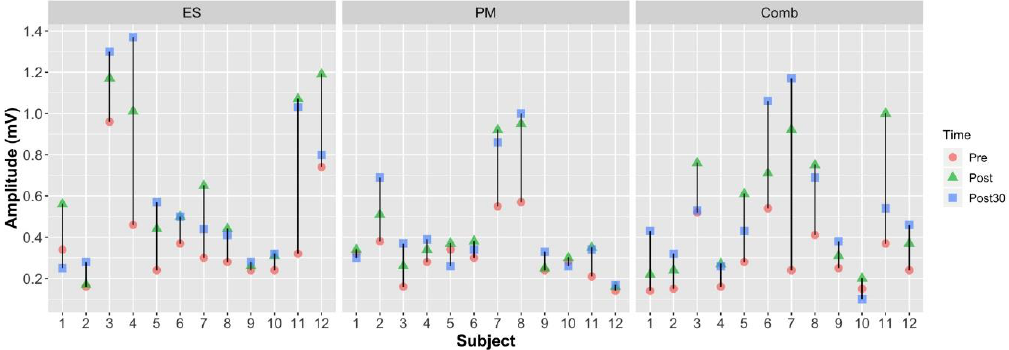
Figure 3. Peak-peak MEP amplitudes for all the subjects for pre- to post- and post-30 raw values.